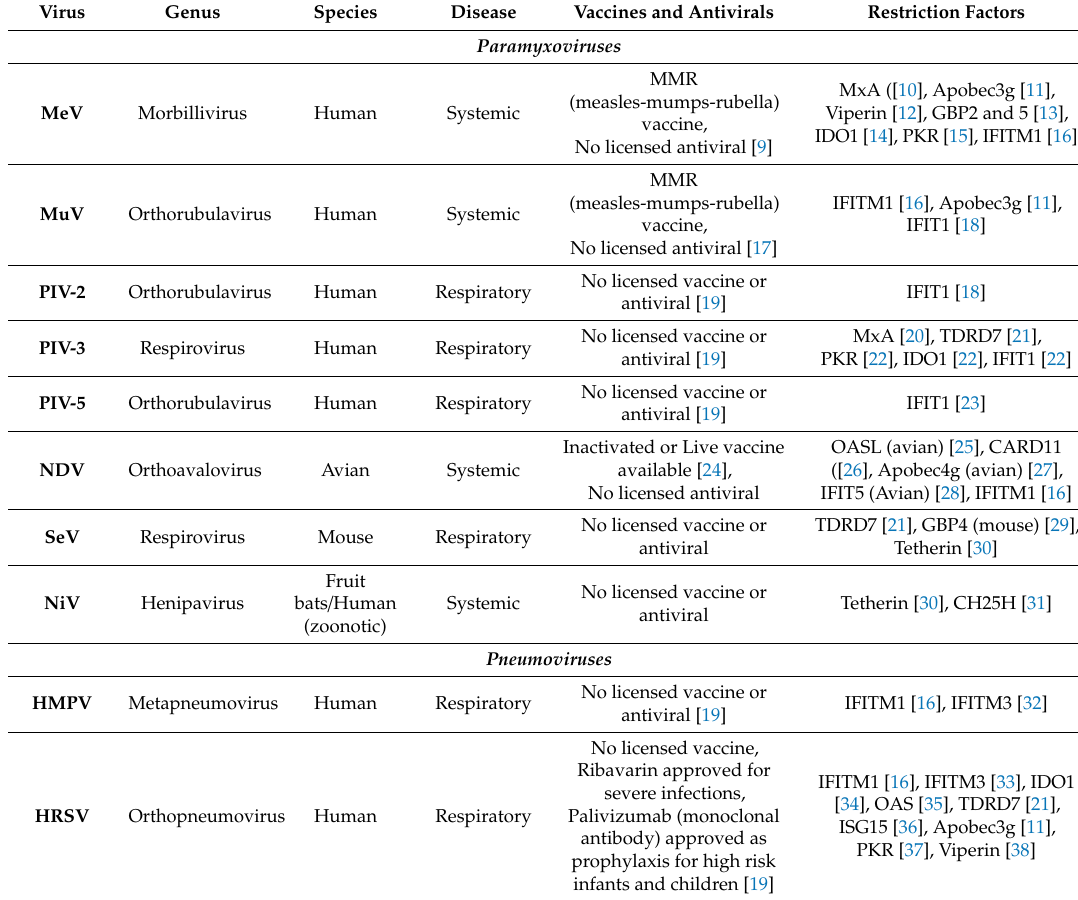
Table 1. Host cell restriction factors with reported activity against paramyxoviruses and pneumoviruses. Virus Genus Species